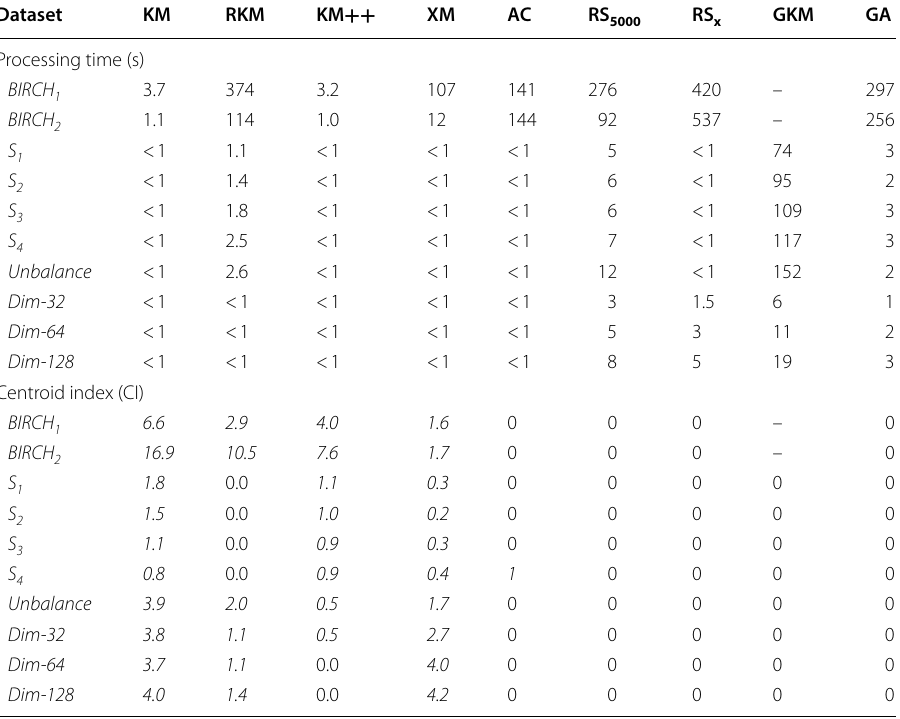
The results of KM, RKM, KM is